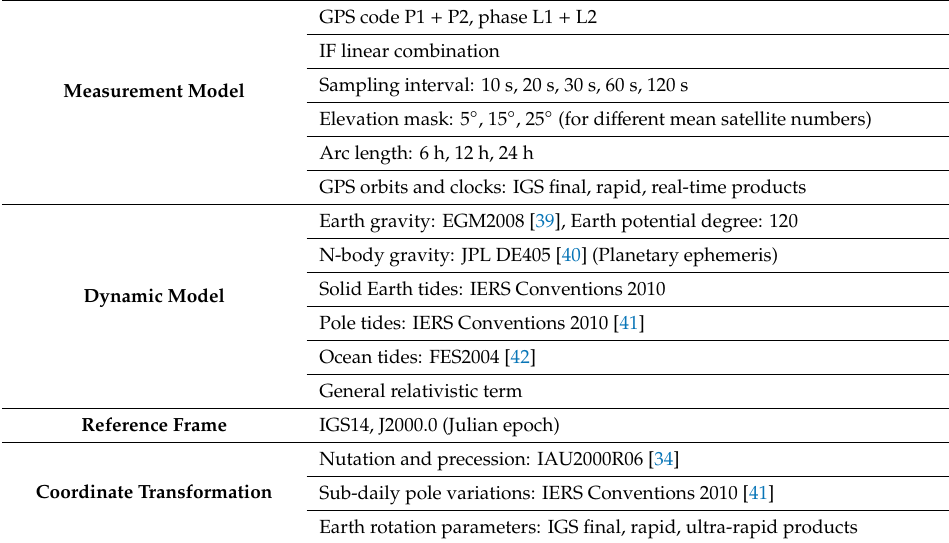
Figure 2. Flow-diagram of the processing procedure and the estimated parameters. n and m are the numbers of the stochastic parameter vectors considered during the estimation in Step 3 and 4, respectively. Table 1. Processing details for the reduced-dynamic orbit determination.